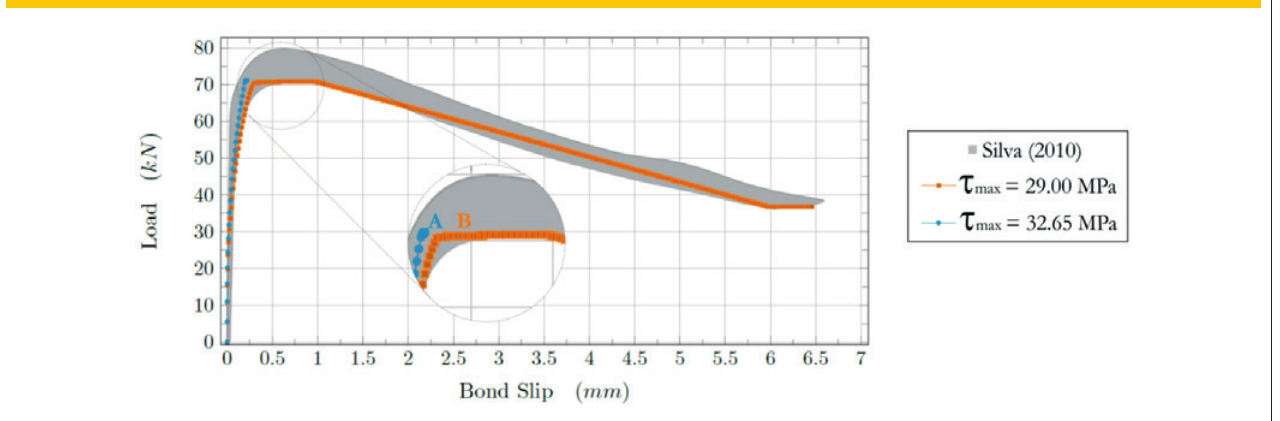
Figure 12 – Experimental and FEM results for concrete C45 and reinforcing bars of